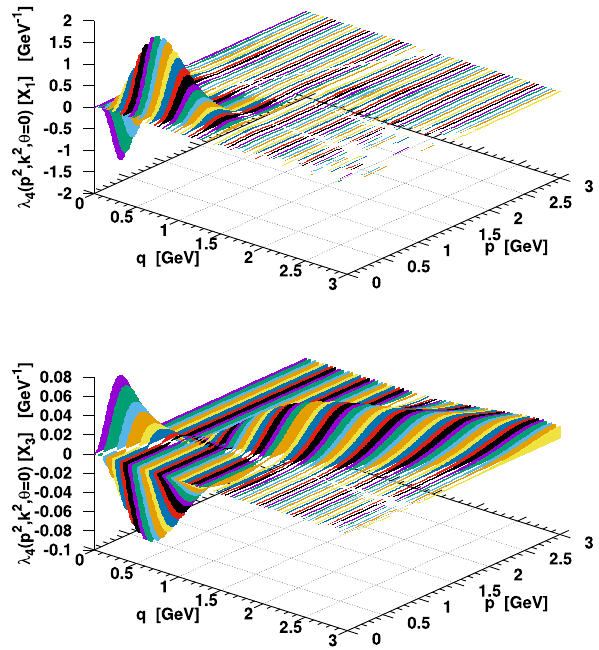
Fig. 9 The contribution proportional to Y 1 (left) and to Y 3 to the form factor